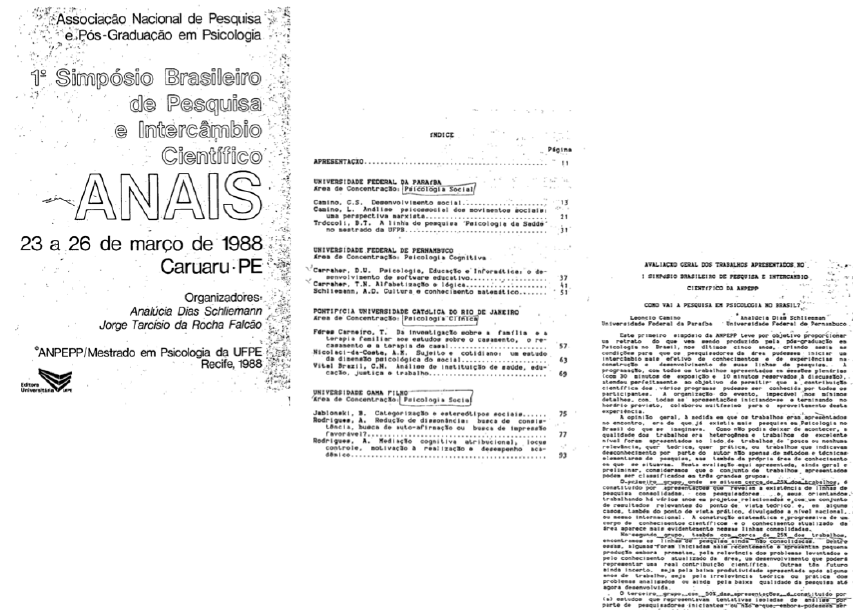
Figure 1 . Cover page, index, and chapter from proceedings of ANPEPP’s First Symposium.